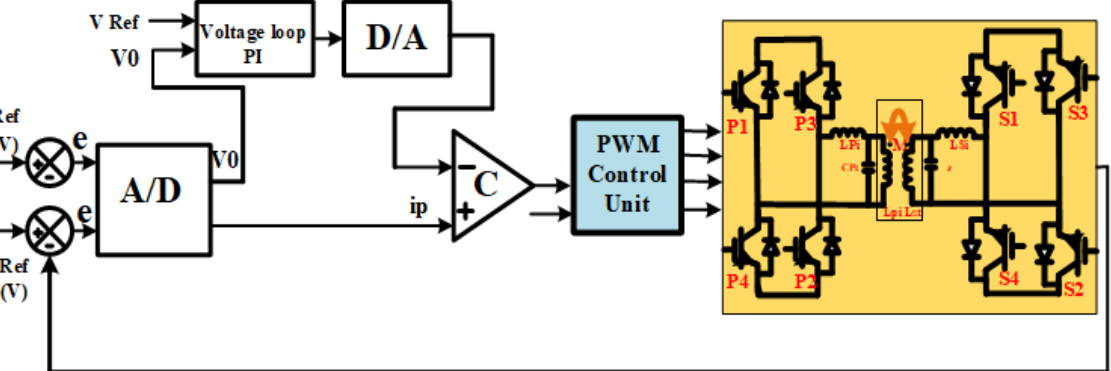
Figure 13. Digital Control-interfaced BWPT system.